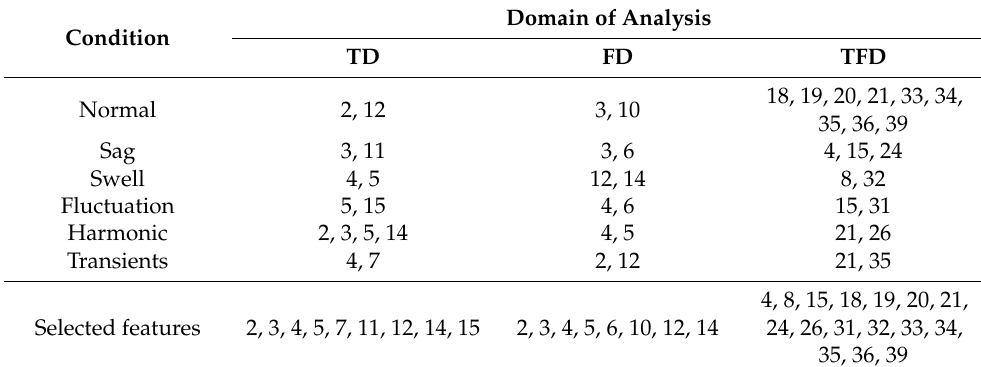
Table 4. Resulting feature selection achieved by the GA–PCA selection structure applied to each eval- uated condition for each analyzed domain with TD = 15, FD = 14 and TFD = 45, where, TD ∈ R TD , FD ∈ R FD and TFD ∈ R TFD